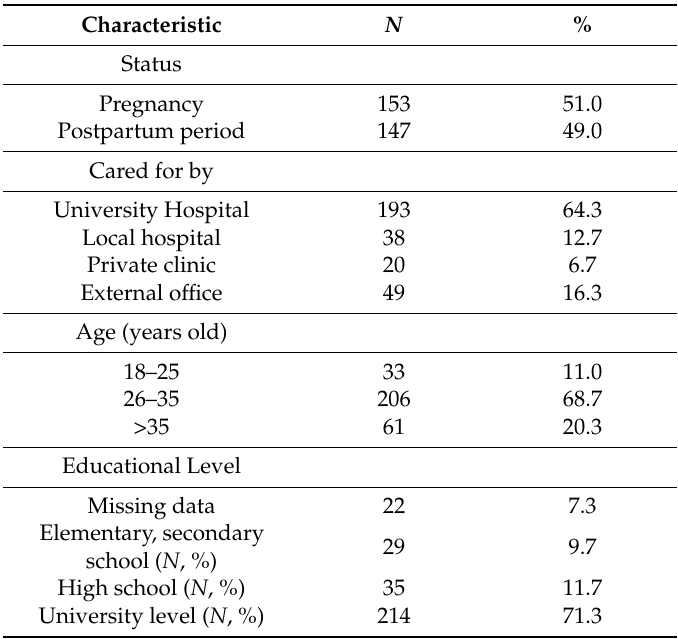
Table 1. Characteristics of women in perinatal period who participated in the quantitative part of the study ( N = 300) [46]. Characteristic N % Status Pregnancy 153